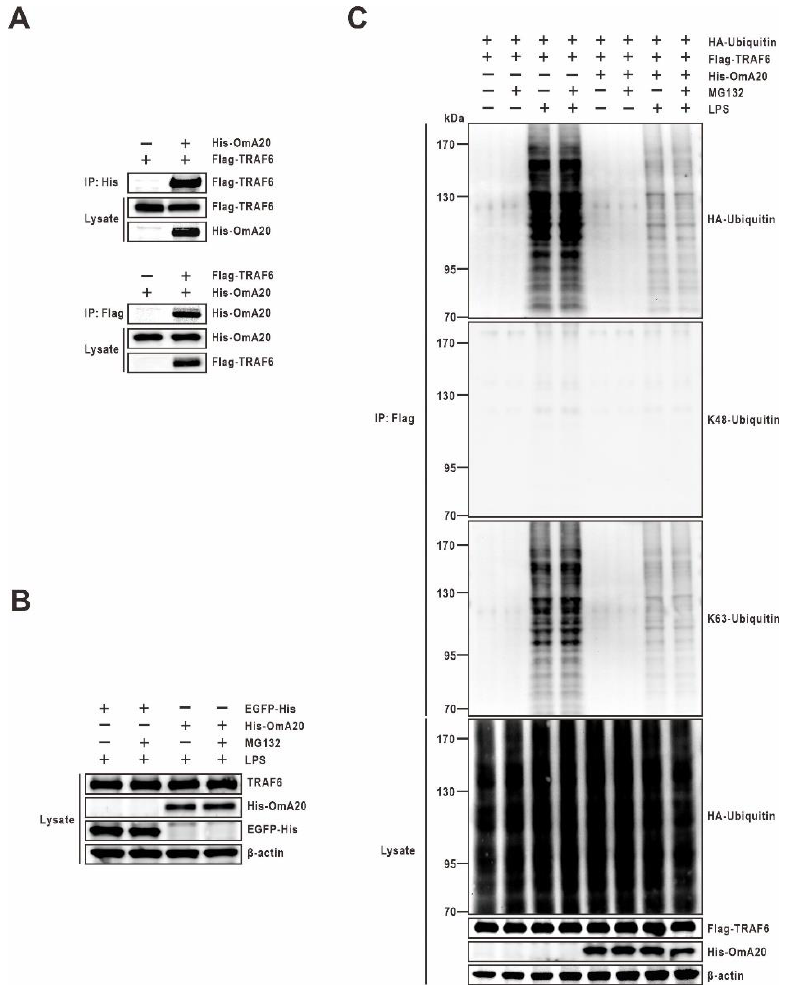
Figure 6. Effect of OmA20 overexpression on the ubiquitination of TRAF6 in RTH-149 cells stimulated with LPS. RTH-149 cells were transfected with expression vectors for various combinations (above lanes) of His-OmA20, Flag-TRAF6, EGFP-His, and HA-Ubiquitin. ( A ) After transfection, cells were stimulated with LPS (10 μg /mL) for 12 h. The His-OmA20 or Flag-TRAF6 complexes were isolated by immunoprecipitation (IP) followed by immunoblot (IB) to detect the interaction between OmA20 and TRAF6. Cell lysates were subjected to IB to detect the indicated proteins. ( B , C ) After transfection, cells (except control cells) were pretreated with 10 μg /mL LPS for 12 h and treated with or without MG132 (25 μM) for an additional 4 h. Cell lysates were subjected to IB to detect the indicated proteins. ( C ) Flag-TRAF6 was isolated by IP followed by IB (with anti-HA, anti-K48-linkage specific polyubiquitin, and anti-K63-linkage specific polyubiquitin antibodies) to examine its ubiquitin conjugation. All data are representative of three or more experiments.